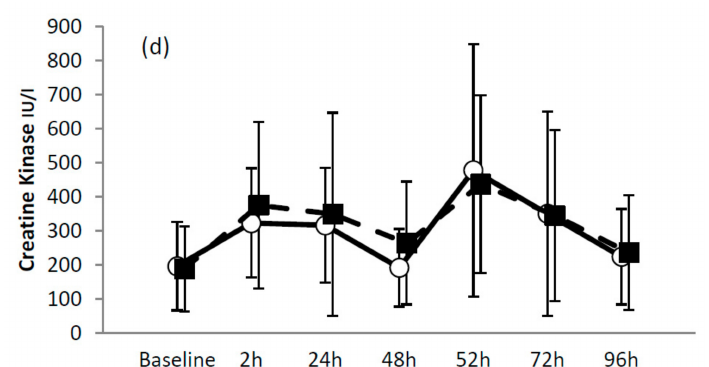
Figure 1. E ff ect of milk vs. carbohydrate on recovery from repeated simulated team-sport games. ( a ) Peak torque 60 ◦ / s for knee flexion; ( b ) 5 m sprint performance; ( c ) Daily Analysis of Life Demands (DALDA) Part B; ( d ) Creatine kinase. Values are presented as the mean ± SD. Cow’s milk (MILK); (cid:110) (cid:35) an energy-matched carbohydrate (CHO). * Possible; ** likely; *** very likely. ◦ / Baseline values for knee extension at 180 s were 106.5 ± 19.8 Nm and 113.0 ± 11.9 Nm for MILK and CHO respectively. Outcomes were trivial (B-24 h, B-96 h) and unclear (B-48 h, B-72 h). For knee ◦ / flexion at 180 s, baseline values for MILK and CHO were 67.8 ± 11.7 Nm and 66.9 ± 11.3 Nm. A benefit for MILK was seen at B-48 h ( − 3.0 ± 2.8% vs. − 8.9 ± 6.3%). Other comparisons were